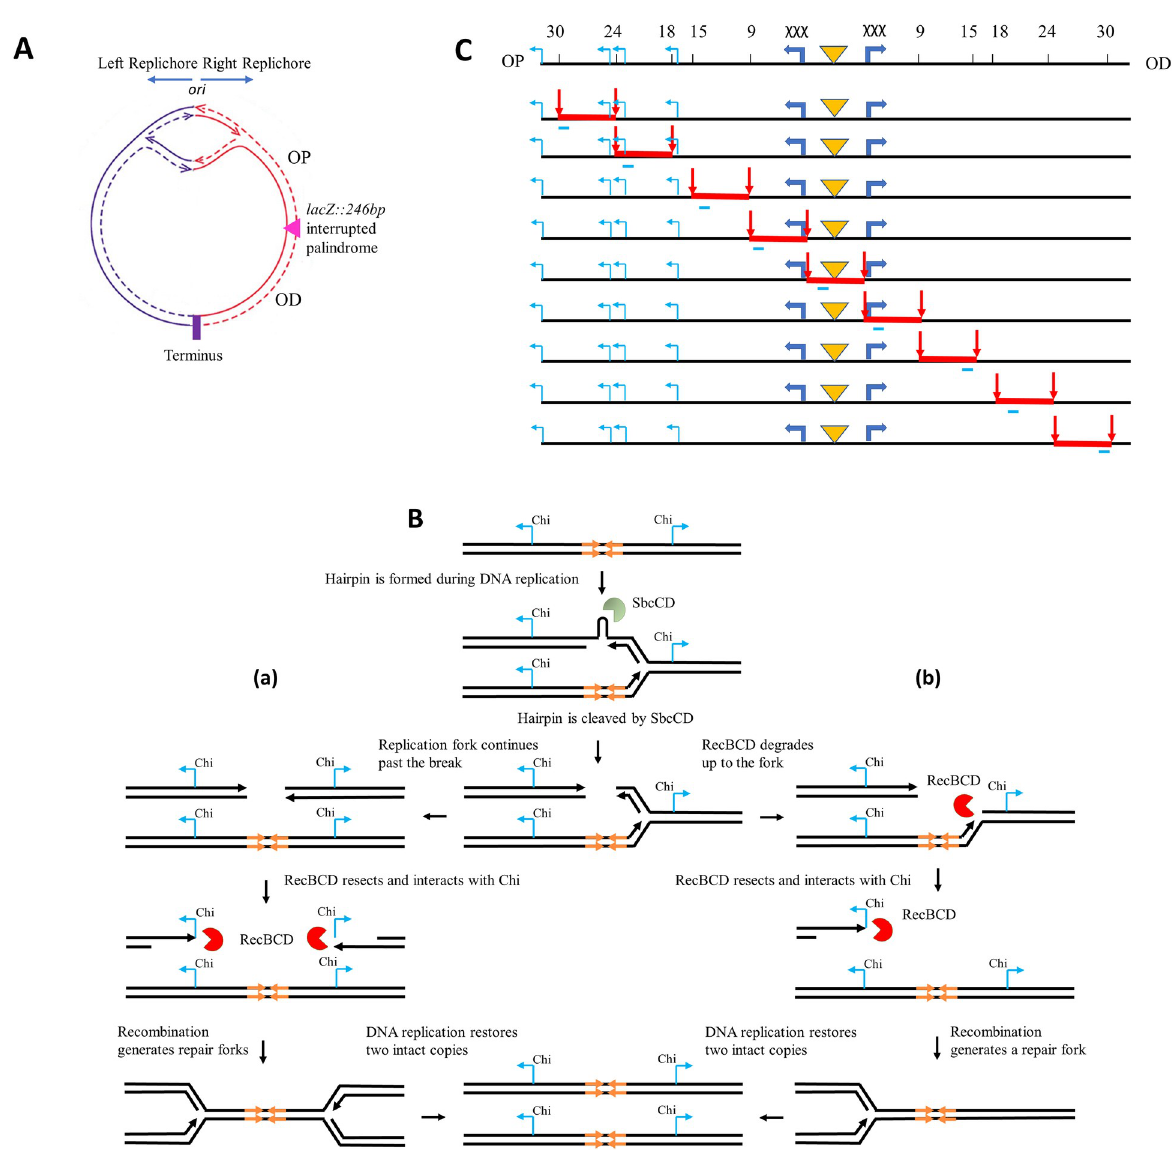
Fig 1. System for analysing Holliday junction and repair fork distribution across a DSB repair region at the E . coli lacZ locus. A) A schematic representation of E . coli circular chromosome showing bidirectional replication originating from oriC and the location of the palindrome within the lacZ region in the right replichore. B) An illustration showing SbcCD-mediated cleavage of the 246bp interrupted palindrome that results in either a two-ended DSB (a) or a one-ended DSB (b). These alternative outcomes are approximately equally probable in a population of cells. The palindrome is highlighted by orange arrows. C) Map of the NotI restriction sites inserted into the DSB region of the E . coli chromosome. The restriction sites and their distance from the palindrome are marked with black vertical lines and numbers (in kb), respectively on the top line. Below it, the fragments that are generated in 9 different strains following NotI digestion are shown by red lines where the restriction sites are shown by red vertical arrows and the probe binding sites are indicated by light blue bars below the fragments. The palindrome is marked by an orange triangle and the triple Chi arrays and endogenous Chi sites are represented by blue arrows. OP represents origin-proximal side and OD represents origin-distal